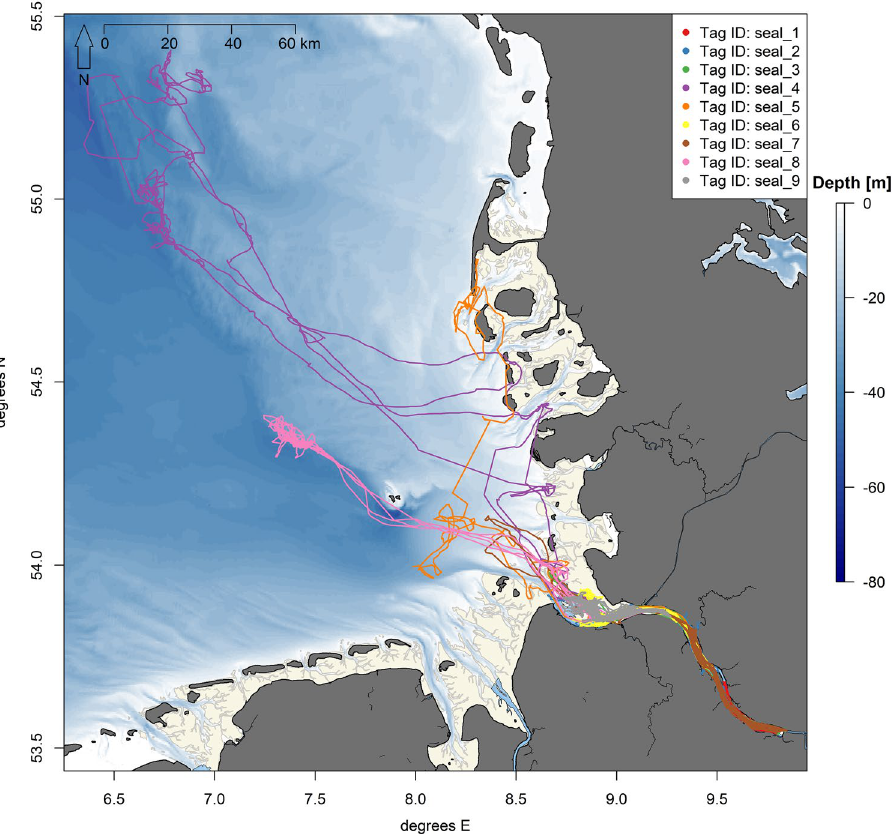
Figure 3. Map showing the recorded tracks of nine harbour seals tagged in the Elbe estuary. Tracks are colour- coded by tag ID. Visualisation was done in R! 3.6.2 35 using R Studio 2021.9.0.351 for Windows 36 (https:// cran.r- proje ct. org/ bin/ windo ws/ base/ old/3.